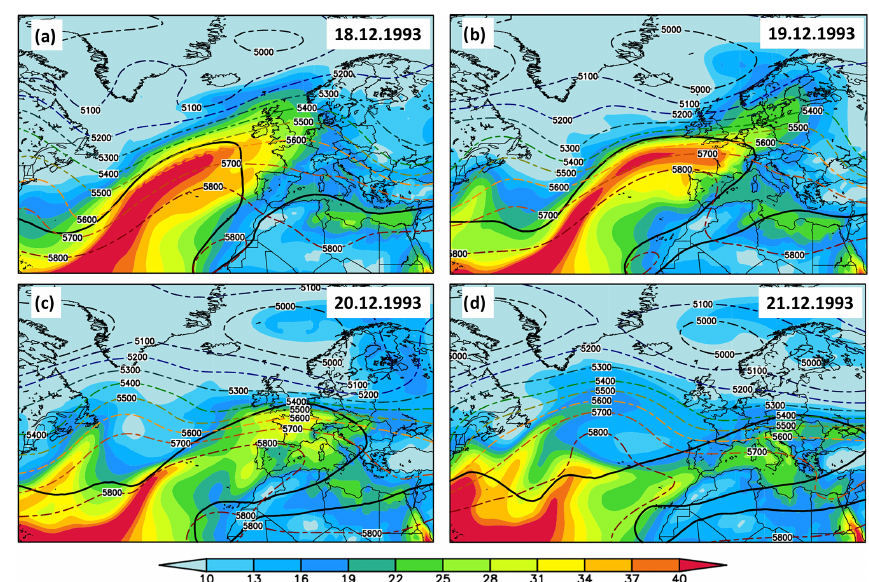
Figure 7. Daily integrated water vapor (IWV; shading) and daily geopotential height at 500hPa (Z500; contour lines) for (a) 18 Decem- ber 1993, (b) 19 December 1993, (c) 20 December 1993 and (d) 21 December 1993. The thick black line in panels (a) – (d) indicates the 2PV contour at 330K. Units: IWV (kgm − 2 ) and Z500